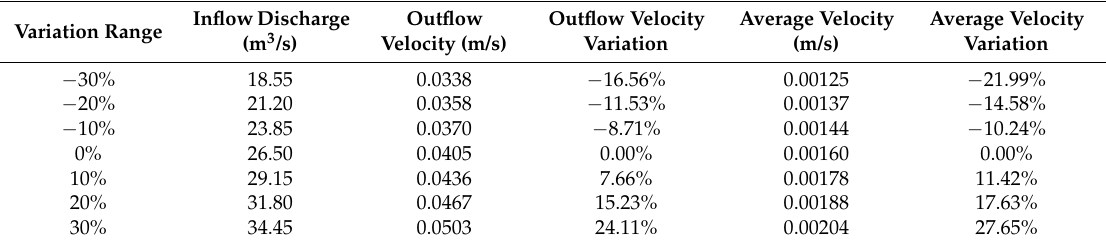
Table 2. Effect of inflow velocity on flow velocity.